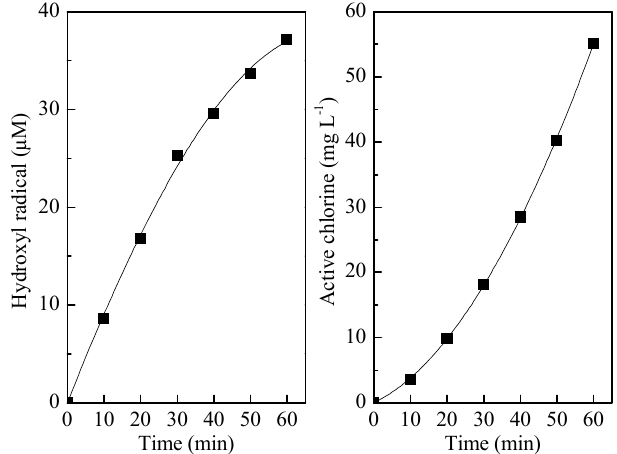
Figure 5. Generation of the hydroxyl radical and active chlorine. Initial pH value of 8.3, applied current density of 20 mA cm − 2 , NaCl concentration of 1.0 g L − 1 , and a flow of 300 mL min − 1 .